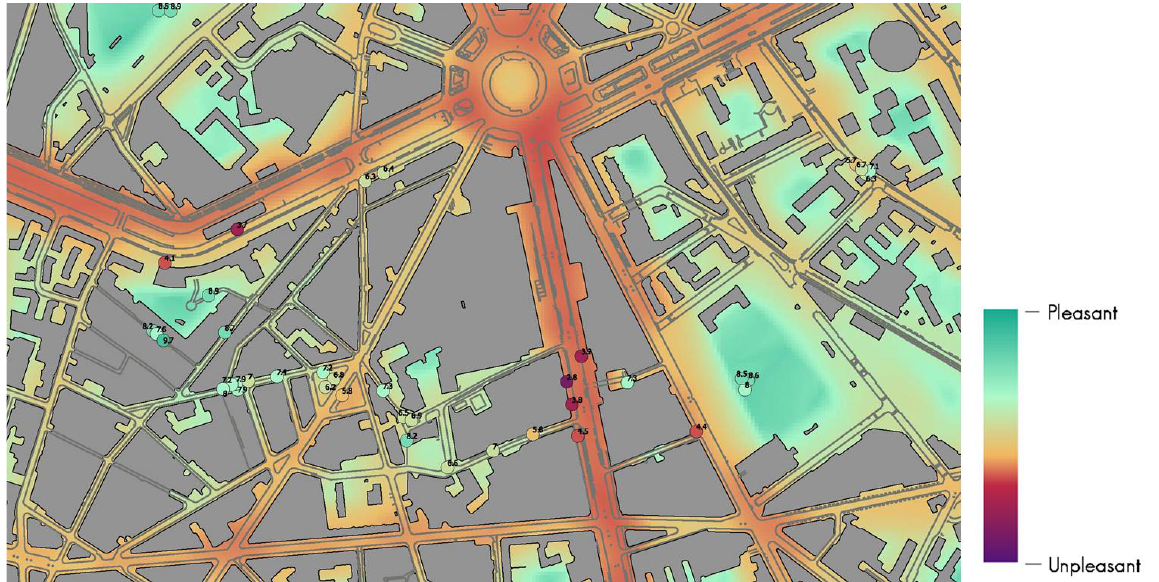
Figure 17: Mapping of sound quality modelled on public space (Eq. 15).The circles represent the mean values of the pleasantness evaluated by participants.